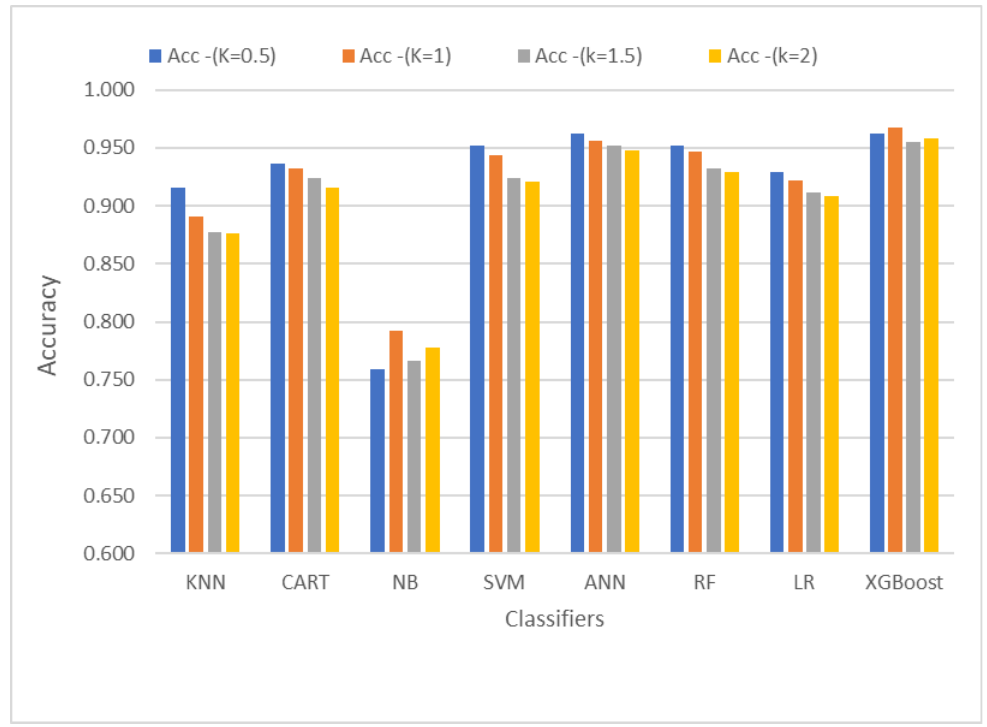
Figure 6. The comparison between the used classifiers in terms of the accuracy with various K values (0.5, 1.0, 1.5, and 2.0).